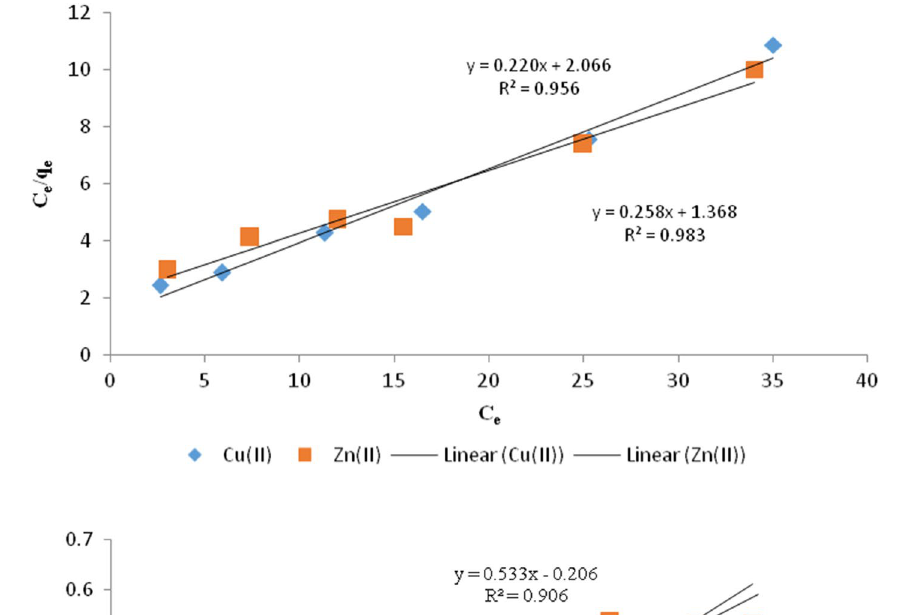
Fig. 4 Freundlich adsorption isotherm model (metal initial concentrations of 10, 20, 30, 40, 50 and 60 mg/L, incubation duration of 10 days, incuba- tion temperature of 28 °C, and shaker rate of 150 rpm)